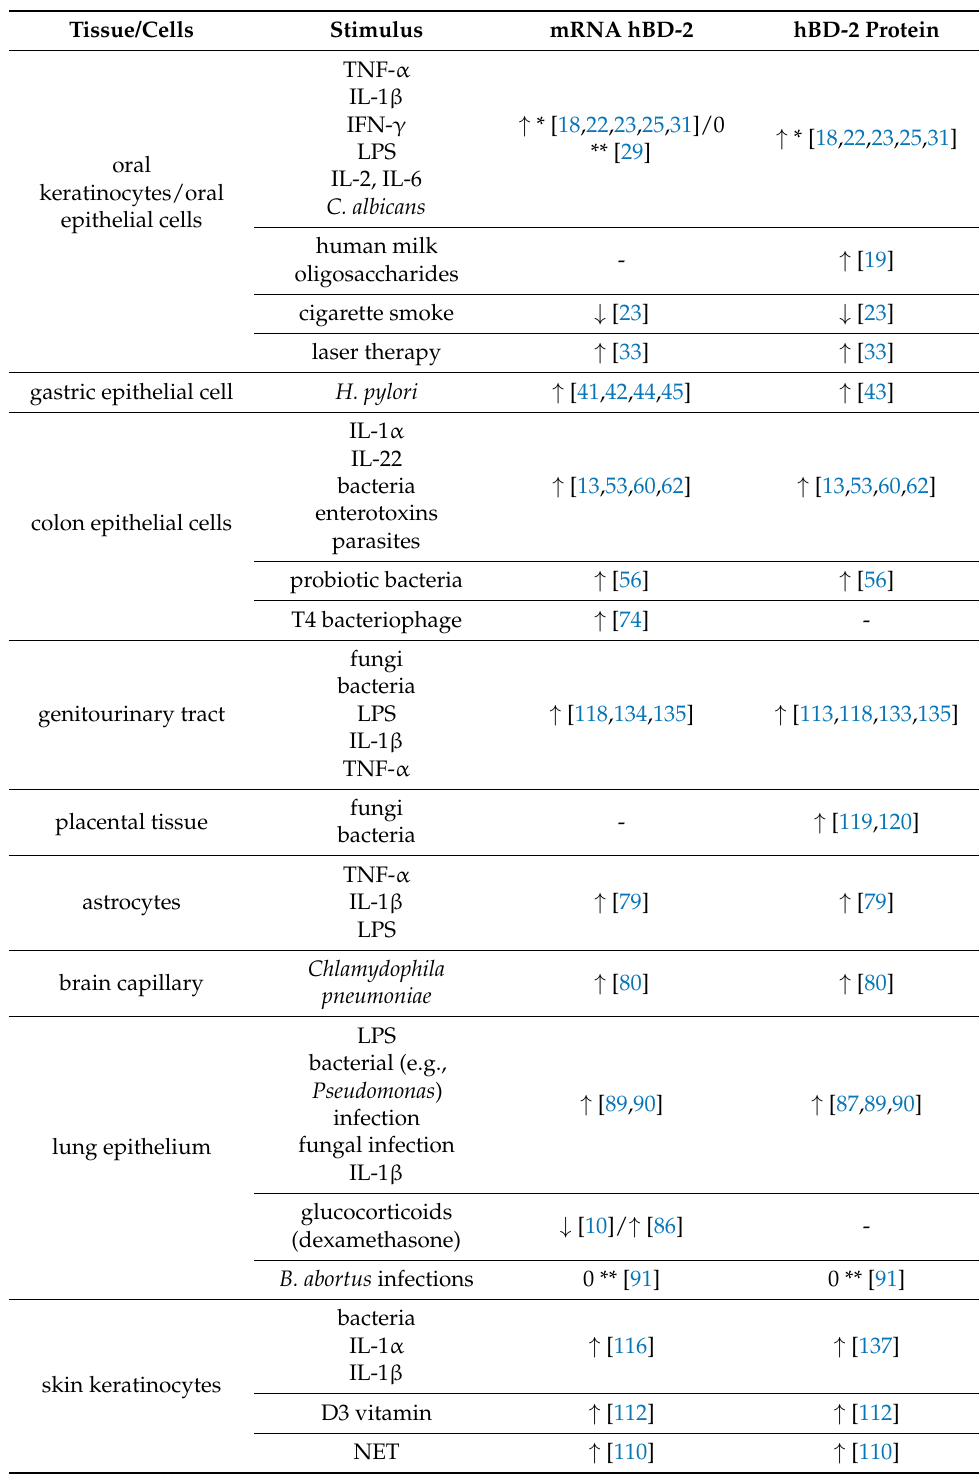
Table 3. hBD-2 gene expression and protein levels in different tissues in relation to external factors and